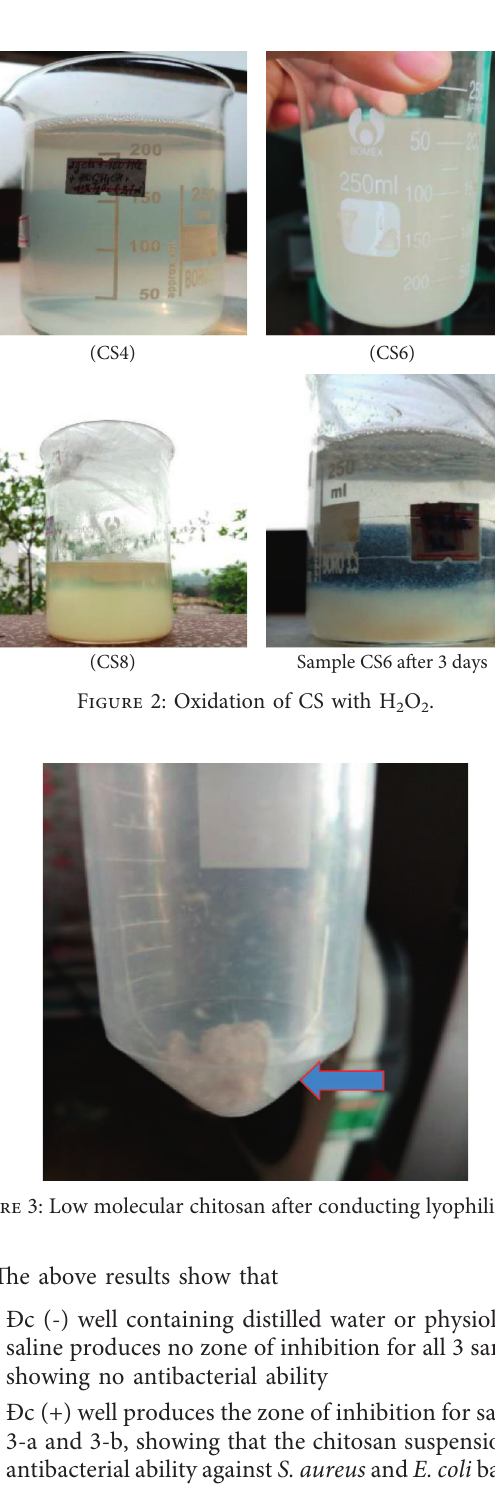
Figure 3: Low molecular chitosan after conducting